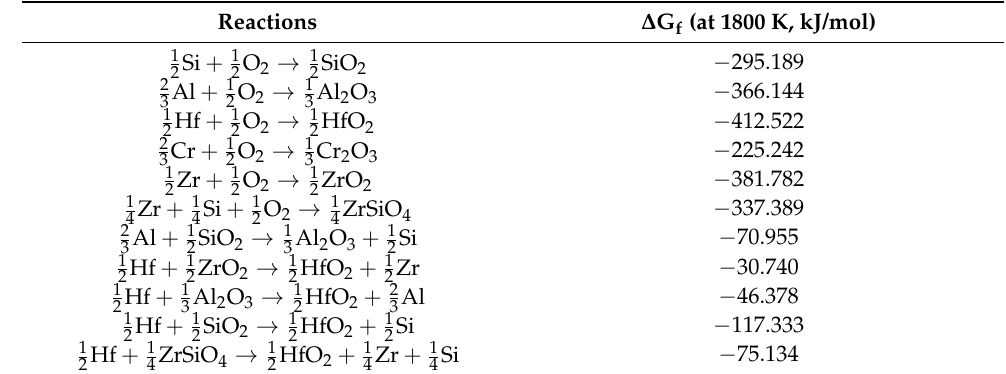
Table 2. Possible chemical reactions and the change in Gibbs free energy at 1800 K (1527 ◦ C) based on thermochemical data